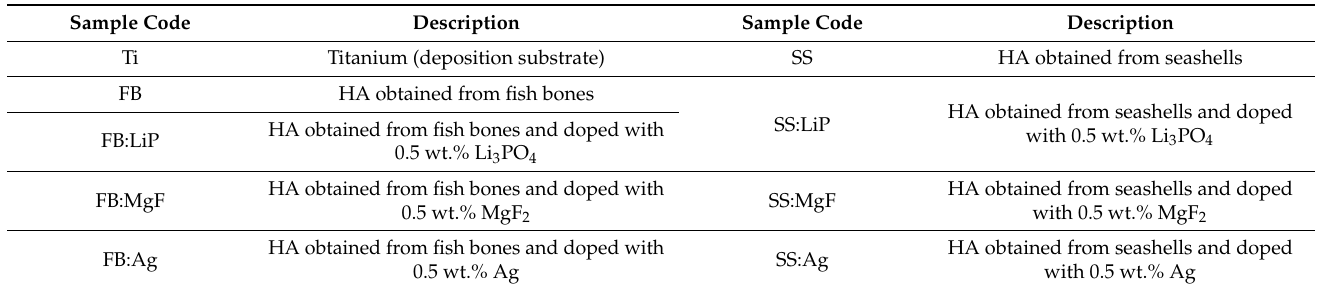
Table 1. Sample codes of all the materials utilized and their